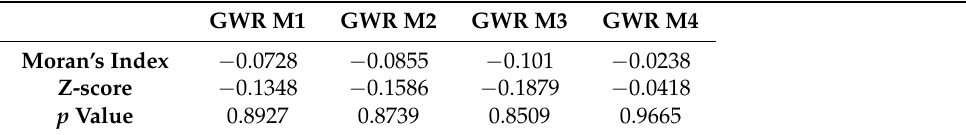
Table 7. Results from spatial autocorrelation statistics for the GWR models.